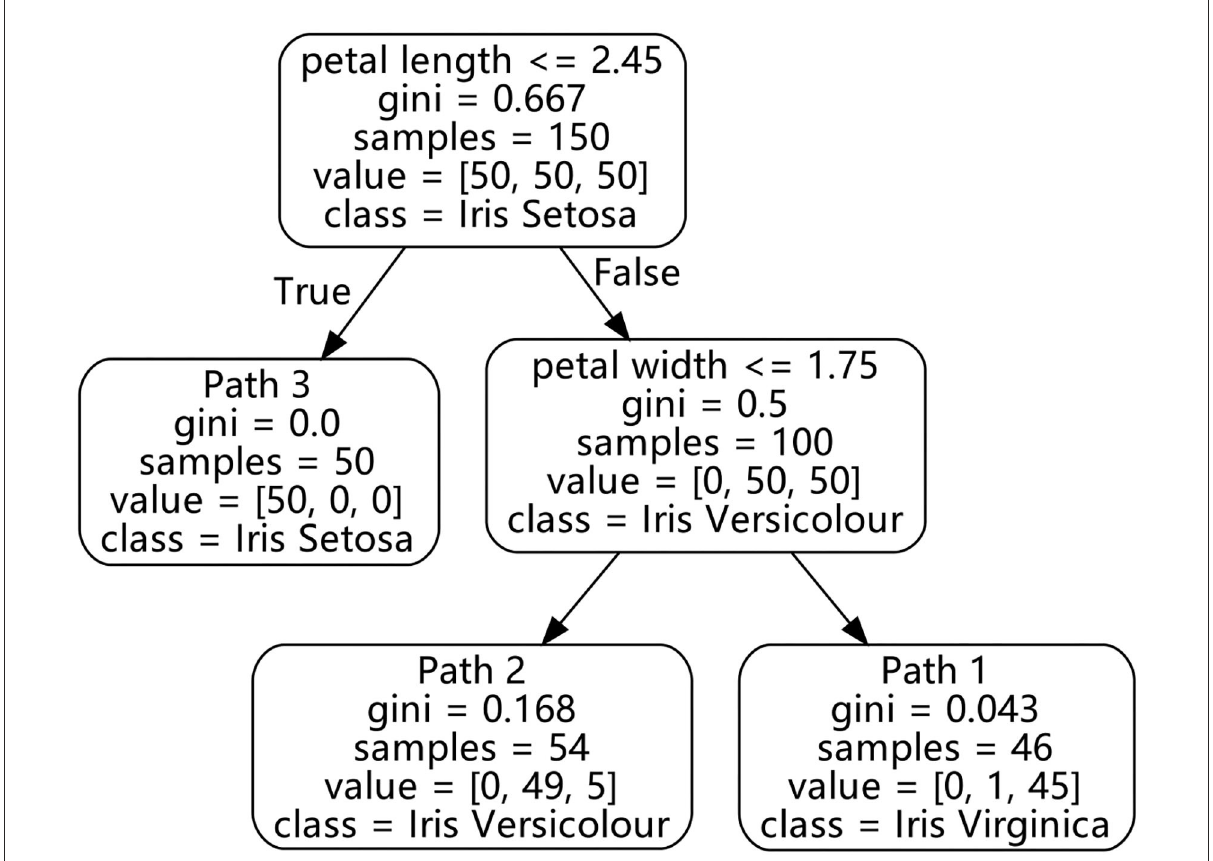
FIGURE4 Classification decision tree for